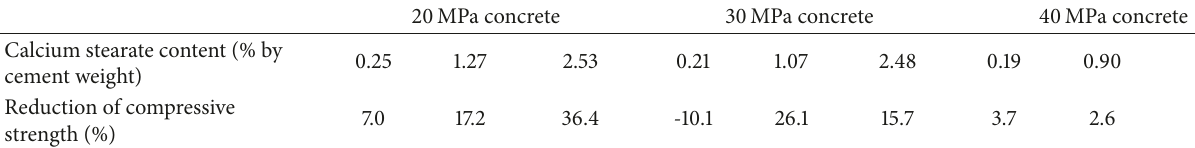
Table 4: Percentage reduction of compressive strength.